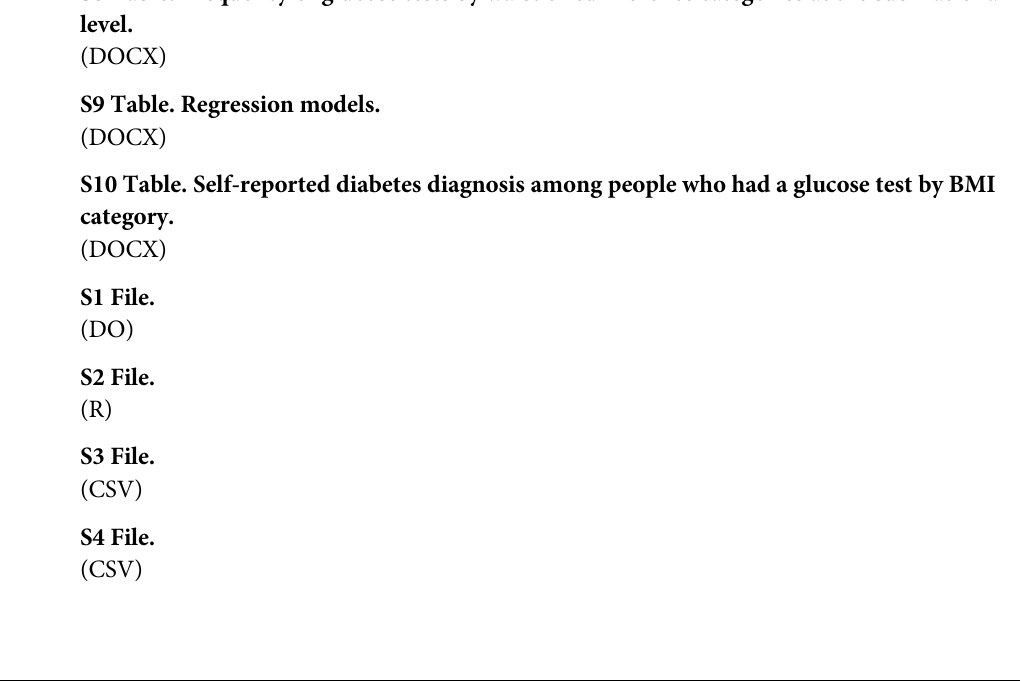
S1 Table. Number of observations in each possible answer to the question about self- reported glucose tests. S2 Table. Absolute number of observations in each possible answer to the question about self-reported diabetes diagnosis. S3 Table. Time trends of self-reported glucose tests in the last year by body mass index cat- egory. S4 Table. Time trends of self-reported glucose tests in the last year by waist circumference category. S5 Table. Frequency of glucose tests by body mass index categories at the national level. S6 Table. Frequency of glucose tests by waist circumference categories at the national level. S7 Table. Frequency of glucose tests by body mass index categories at the sub-national level. S8 Table. Frequency of glucose tests by waist circumference categories at the sub-national level. S9 Table. Regression models. S10 Table. Self-reported diabetes diagnosis among people who had a glucose test by BMI